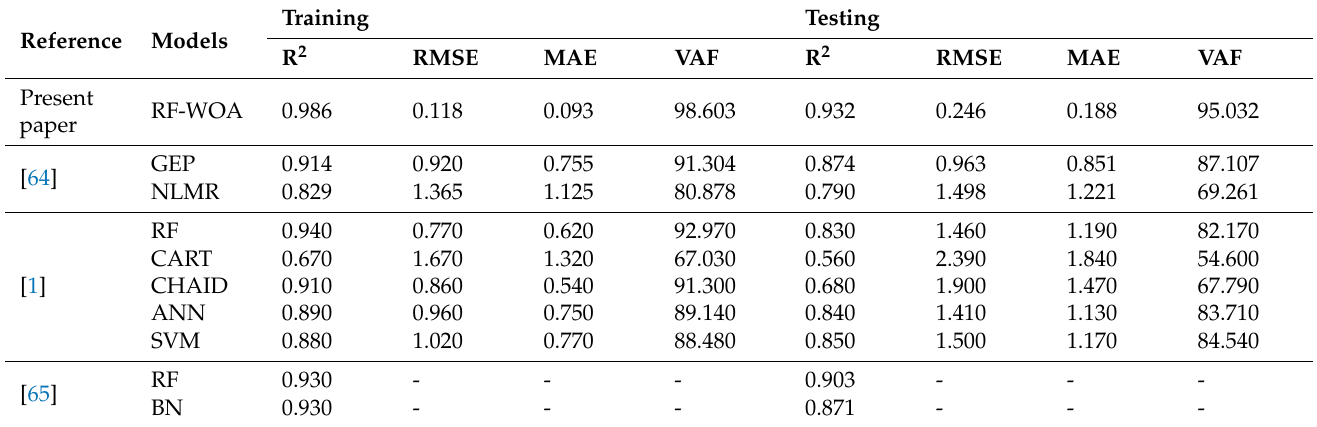
Table 7. Results of the evaluation metrics of the models that used the same